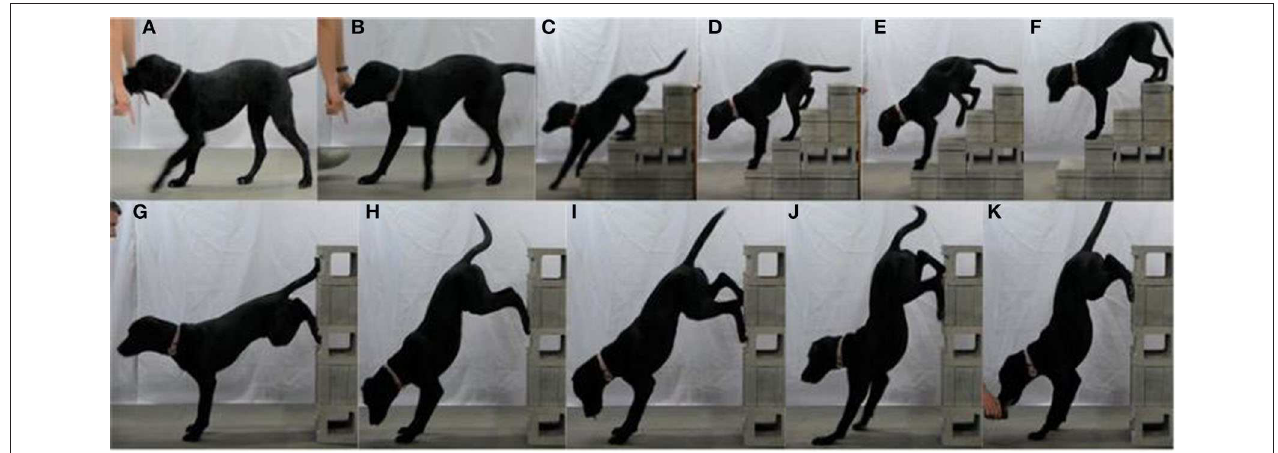
FIGURE 8 | (A,B) Show the first progression of Back-up on the ground. (C–F) Shows a more advanced progression of the Back-up, backing up stairs. (G–K) Shows another advanced progression of the Back-up, backing up a vertical